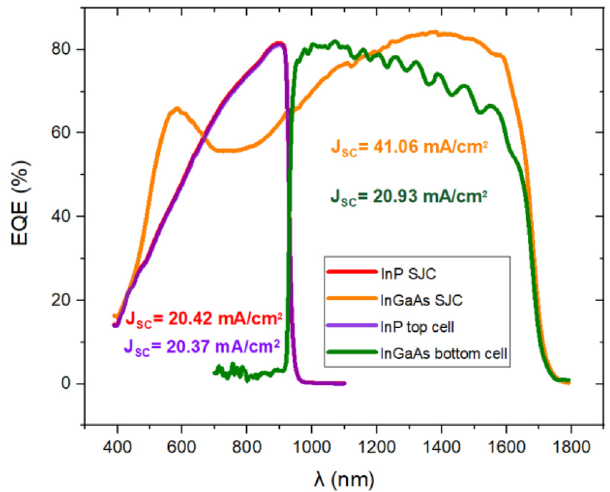
Fig. 4. EQE characteristic of the InP/InGaAs tandem solar cell. It was obtained by separately measuring the contributions of the top (violet line) and bottom (green line) cells. The results are compared with the ones obtained from the single cells (red line for InP and orange line for